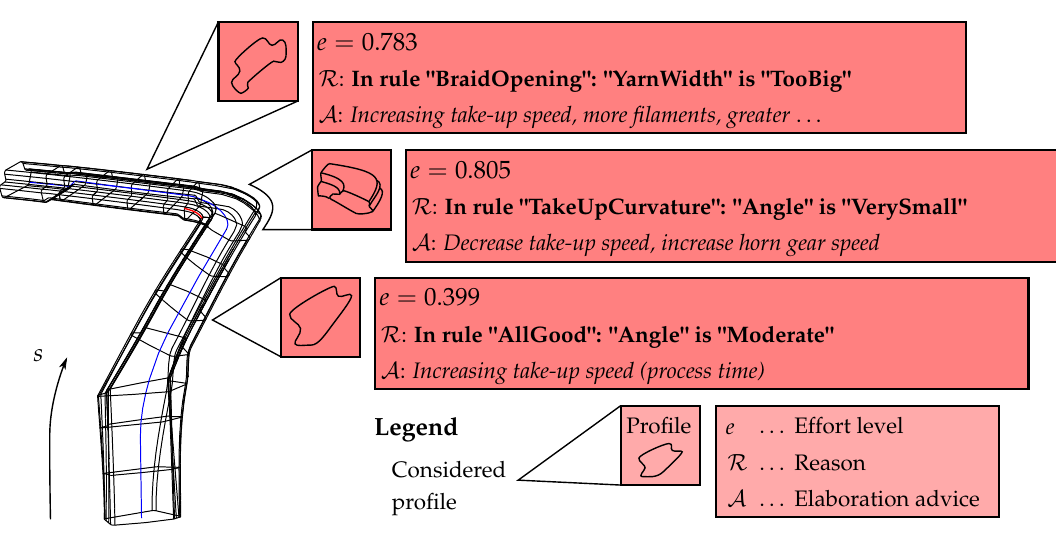
Figure 17. CAE capabilities of the proposed